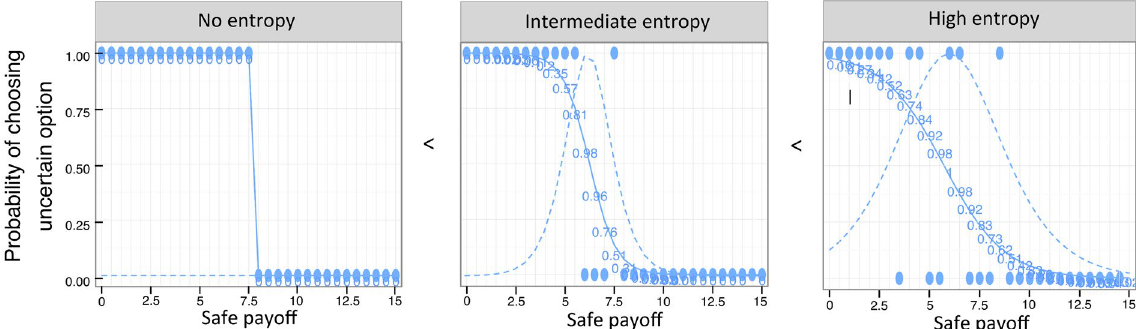
Figure 6. Illustration of entropy. Circles represent choices (1 = uncertain option, 0 = safe payoff) by three different participants. Solid lines are logistic fits to those choices, estimating the probability of choosing a potentially high paying but uncertain option, relative to a lower paying but safe alternative. Dashed lines represent the entropy related to the same logistic fits. The participants in the left most panel uses a “perfect threshold” strategy (thus, he/she exhibits no entropy). The participants in the middle and right panels have similar thresholds to the one on the left, yet they exhibit progressively higher levels of